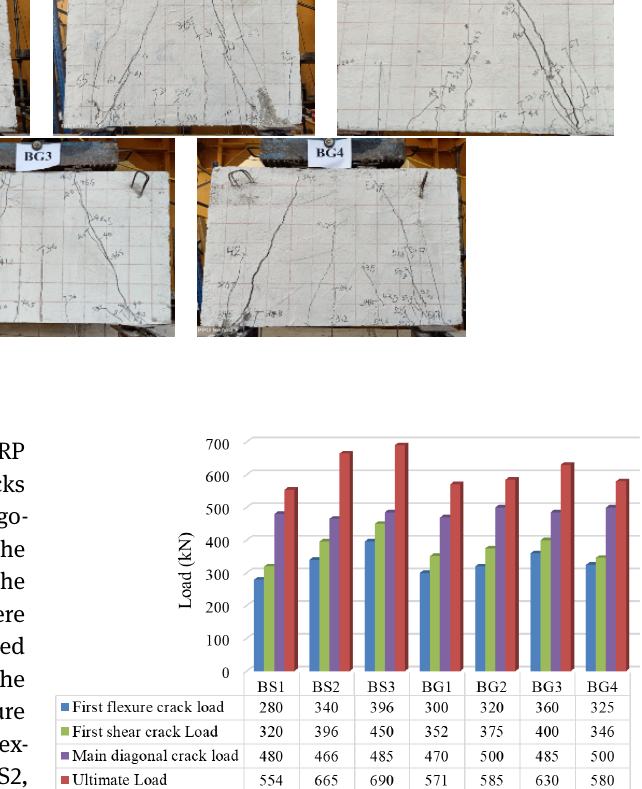
Figure 5: Load for the experimental deep beam test result